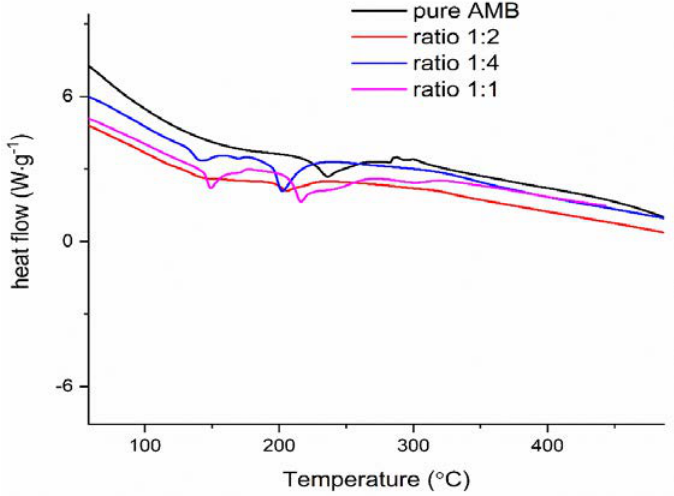
Figure 8. The DSC curves of pure AMB and AMB-lactose mixtures in different ratios .